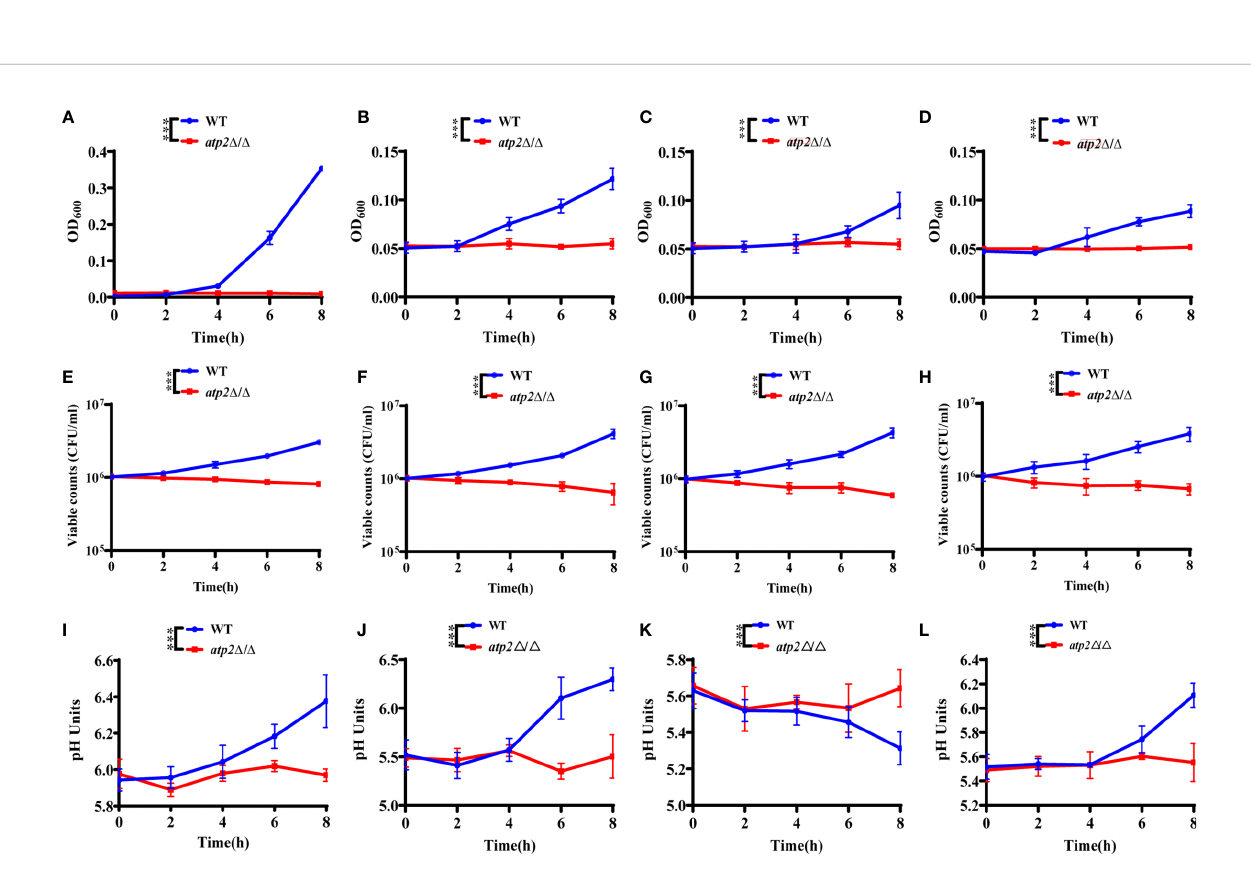
FIGURE 5 | C. albicans cells lacking ATP2 are unable to utilize alternative carbon source. The growth (A – D) , viability (E – H) , and pH (I – L) of WT and atp2 D / D cells in YNB medium plus 2% CAA, GLcNAc, oleic acid, and lactate over 8 h. In (A – L) , the assays were performed in triplicate.*** P <0.001; by two-way